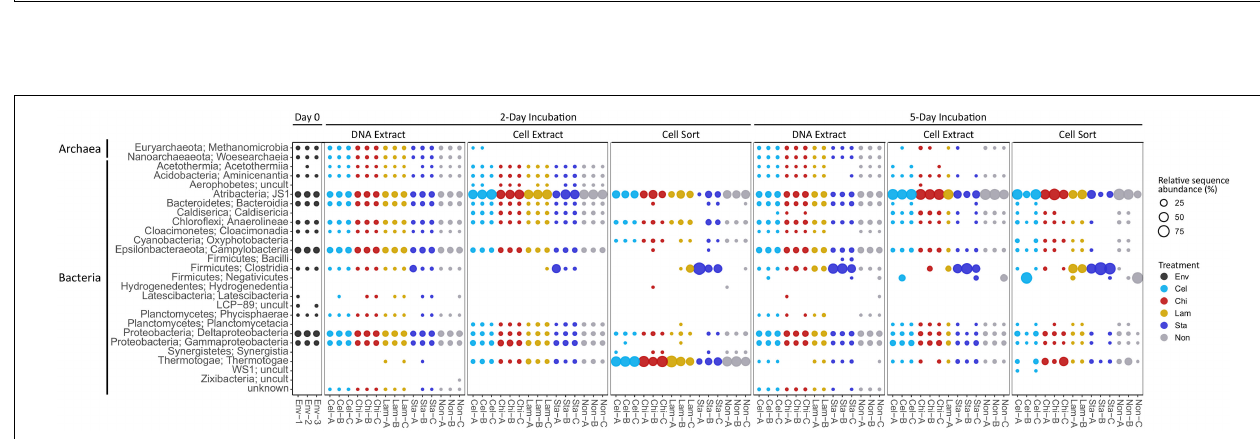
Frontiers in Microbiology |